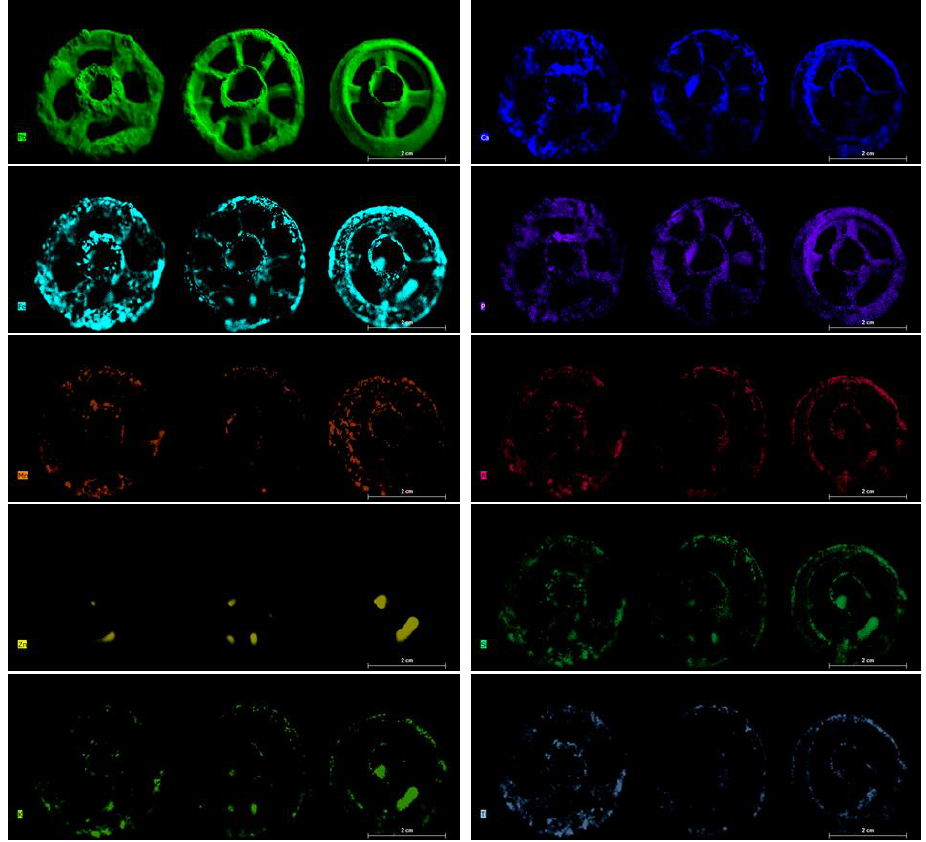
Figure 4. Elemental maps for the detected elements of the three ornamental jewellery items. The Cu map is not shown due to the extremely low content of this element.